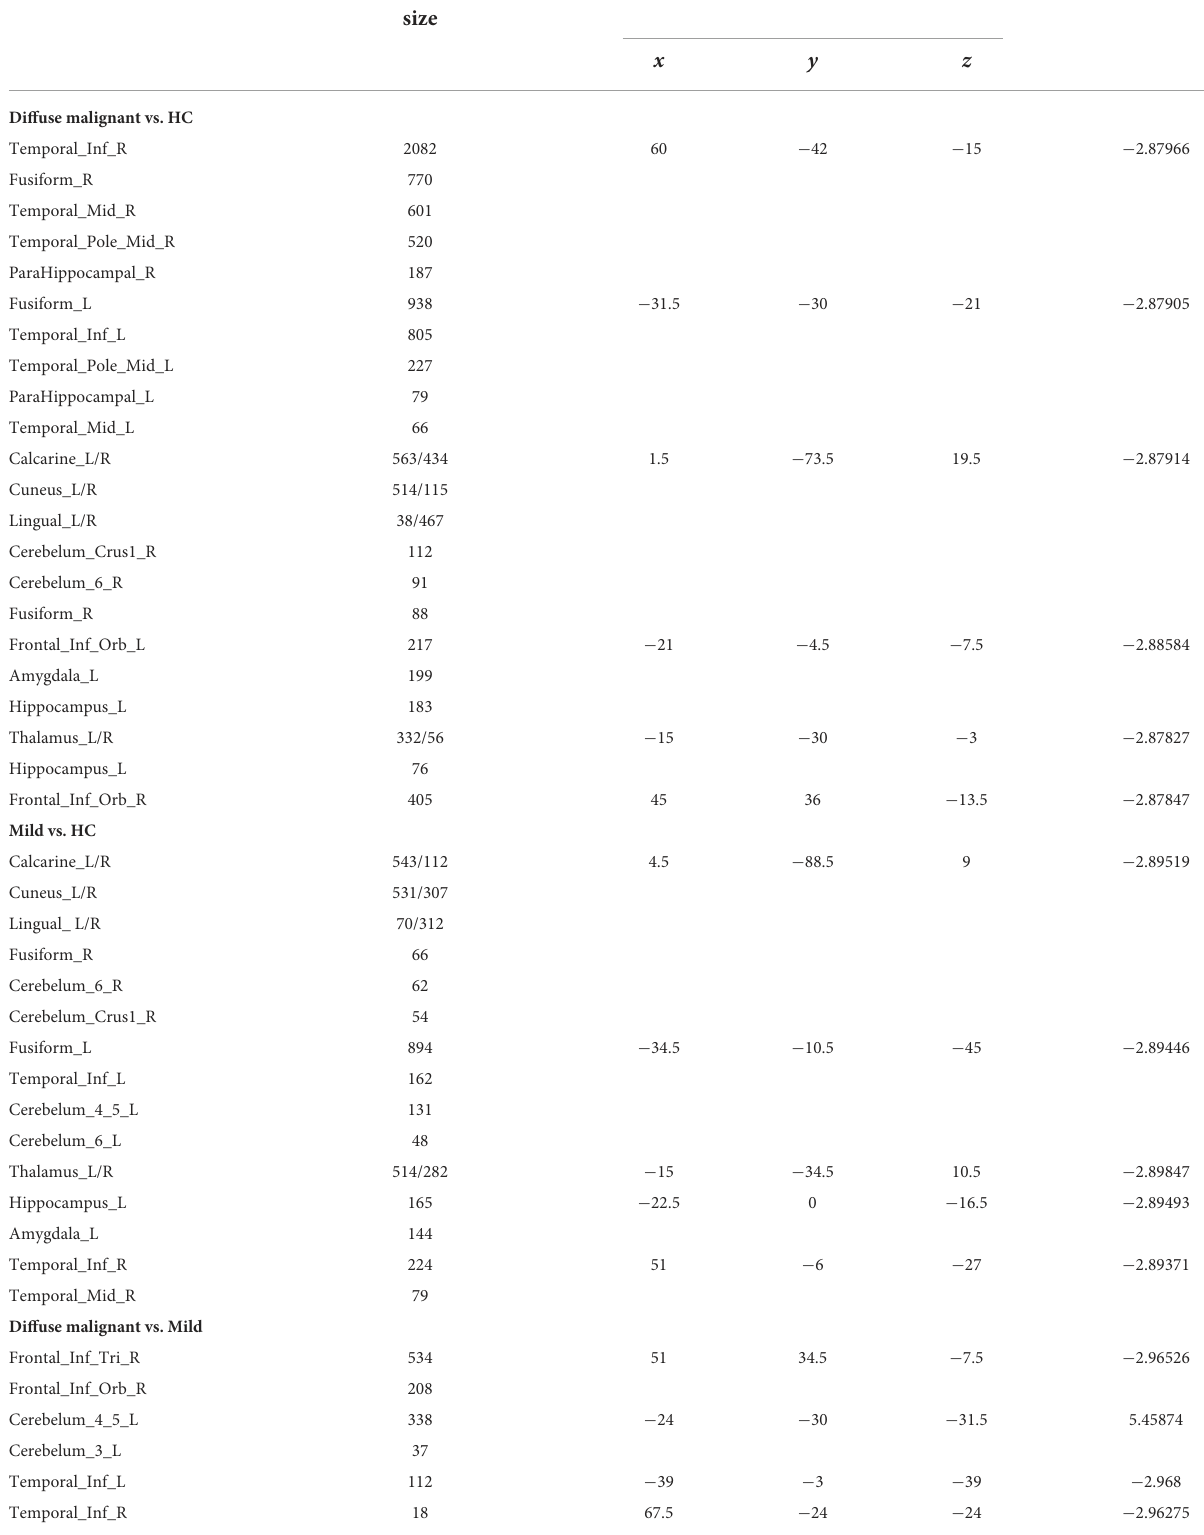
MNI coordinates Peak t- value size x y z